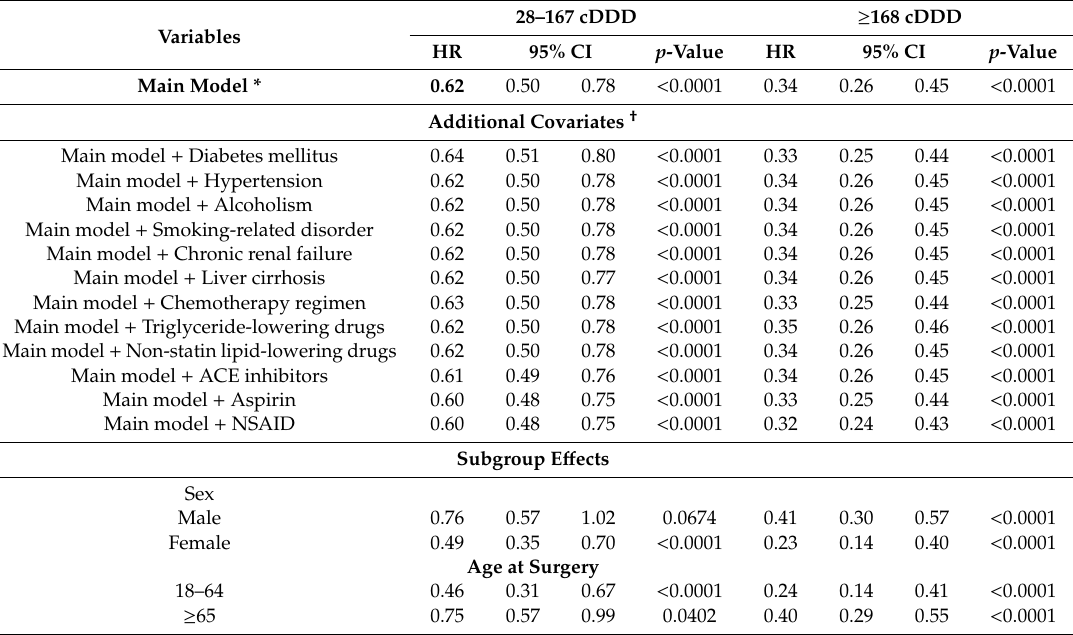
Table 2. Adjusted hazard ratios (HRs) of overall survival of gastric cancer patients after surgery and adjuvant chemotherapy associated with statin use after surgery during the follow-up period in the matched cohort. 28–167 Variables